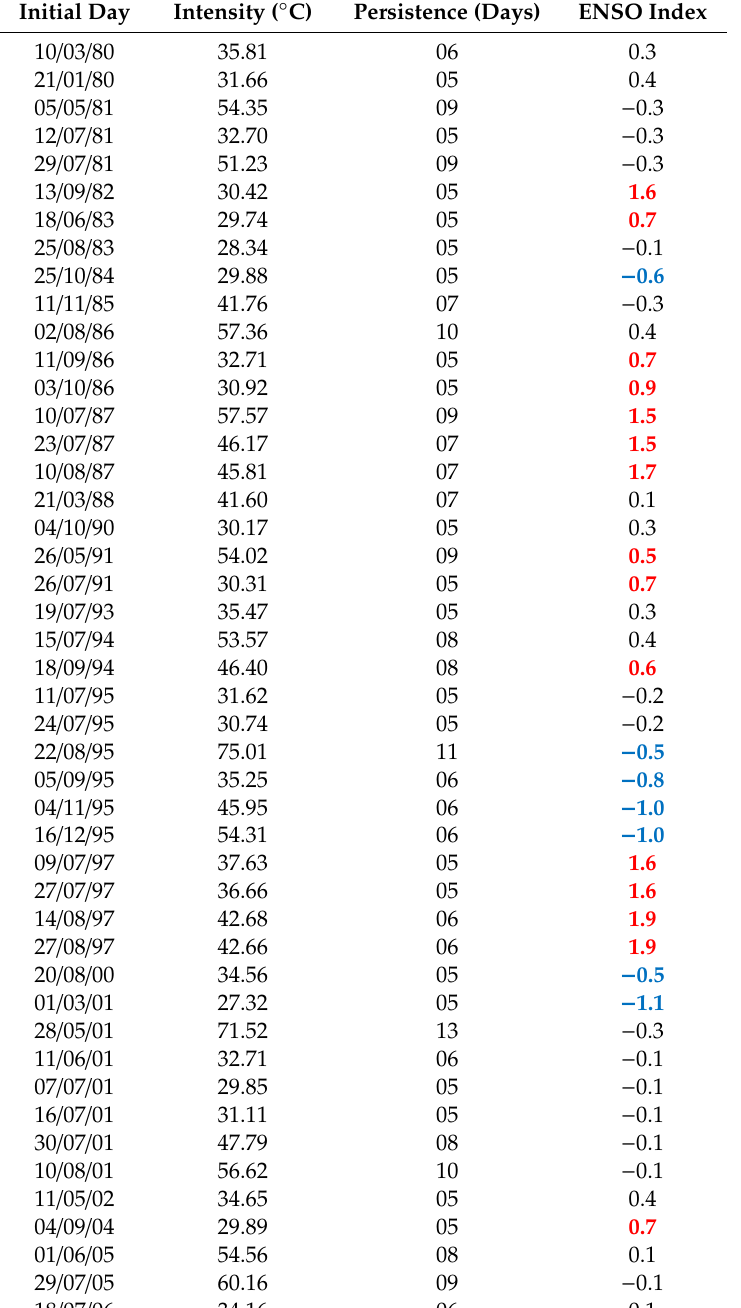
Table A1. Heat waves’ initial day in region 1, intensity (cumulative Tmax anomalies) of each heat wave, its persistence and index values of